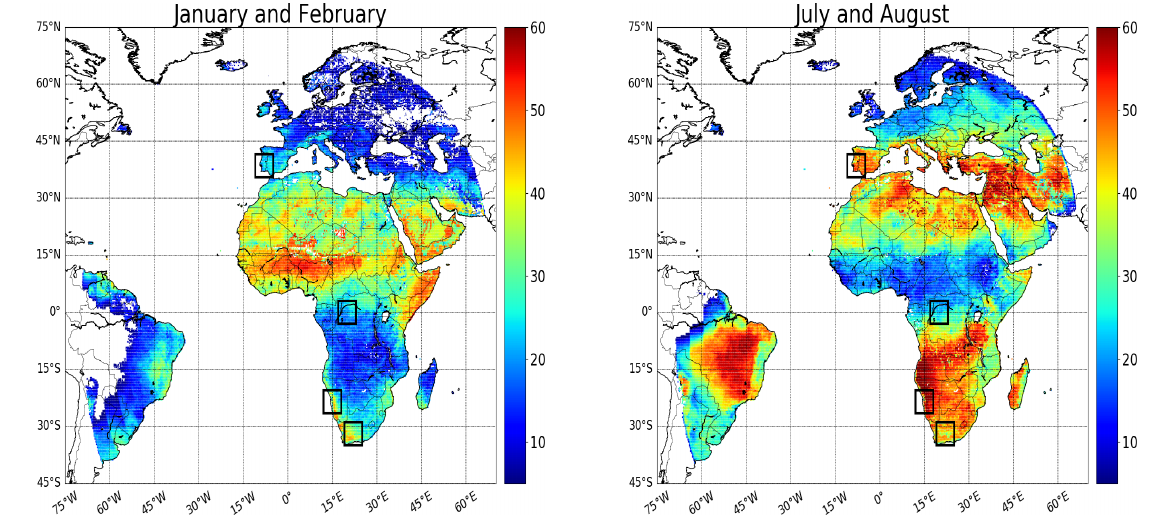
Figure 2. Number of clear-sky collocations between ISCCP and ERA5 for January–February ( left ) and July–August ( right ) 2010. From north to south, the selected regions are in: (1) Portugal, (2) Congo, (3) Namibia and (4) South